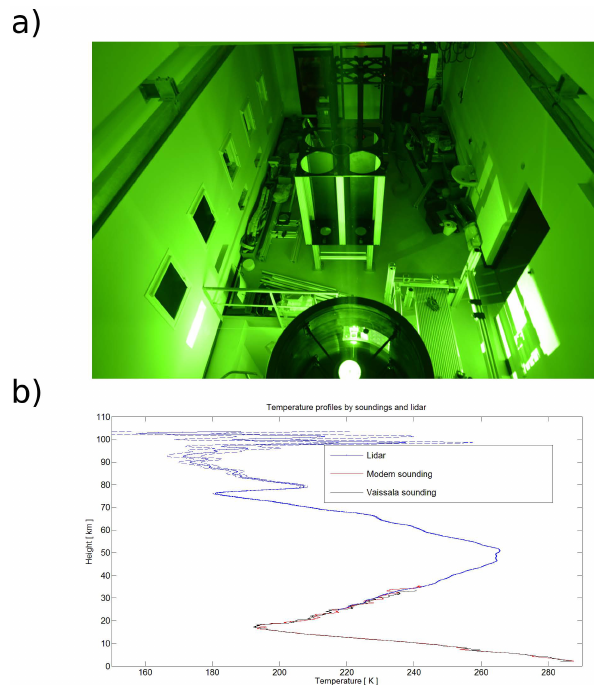
Fig. 3. (a) Photo showing the optical reception of the three lidar sys- tems: water vapor and temperature at the foreground, tropospheric ozone at the middle and stratospheric ozone at the background. The lasers are in the room on the left and the spectrometers in the room on the right. (b) Temperature profiles on 2 April 2013 with M10 Modem radiosonde and lidar at Maïdo. Vertical ranges for lidar, Modem and Vaisala Soundings are respectively 24–90km, 2–35km and 2–33km above sea